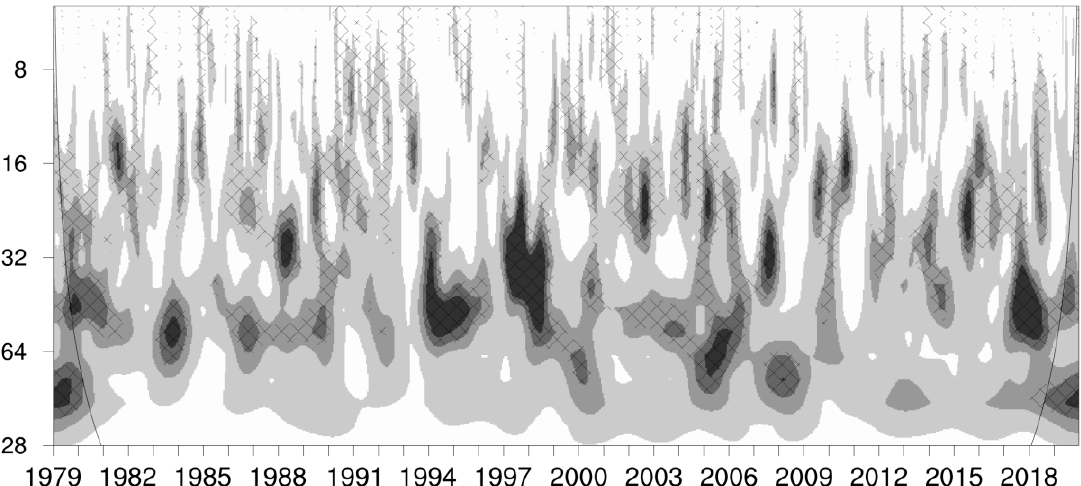
Figure 2. Wavelet spectrum of EASM index sequences from 1979–2019 (the abscissa is time and the ordinate is period (day), grid area passes 95% significance test).